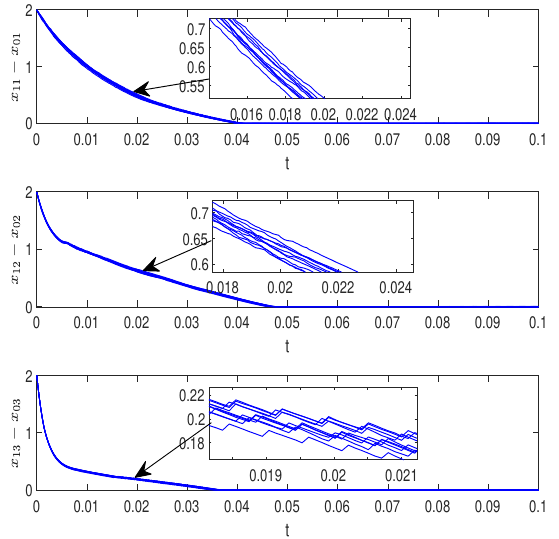
Figure 2. Ten paths of the tracking error between the 1st subchain and the leader with protocol Fig.2. 10 paths of the tracking error between the 1-th subchain and the leader with protocol (4.2).